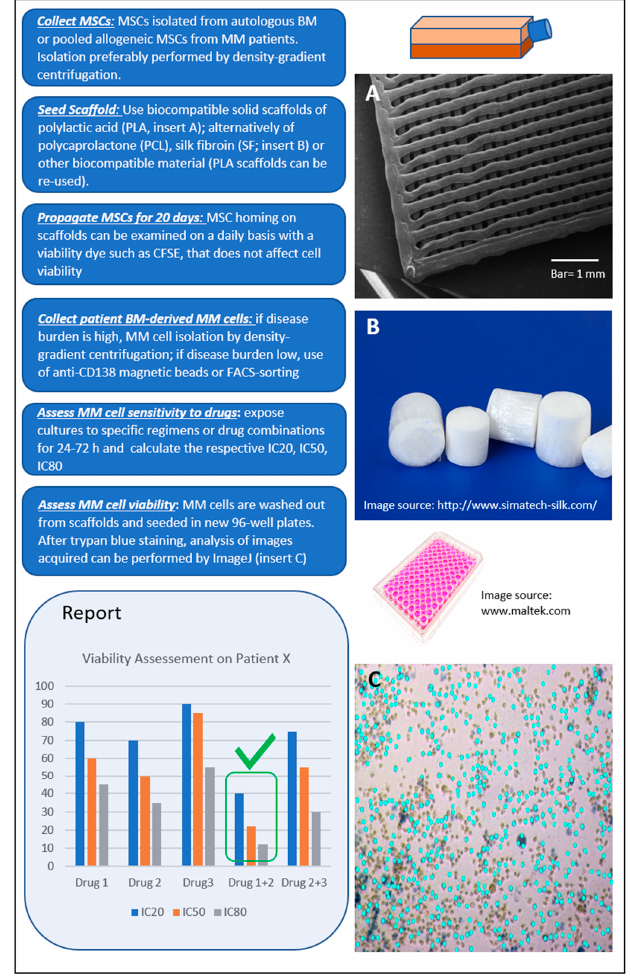
Figure 2. Proposed ex vivo 3D assay simulating the bone marrow (BM) microenvironment of multiple myeloma (MM) patients. Workflow shown from top left to bottom left. The report contains information on patient-specific effectiveness of tested therapeutic agent(s) selected by clinicians. In the example shown, the best response of patient X is to Drugs 1 + 2 (green tick mark).